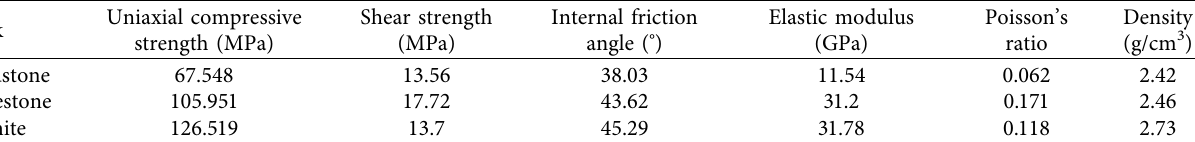
Table 1: Primary physical parameters of 3 rock samples.